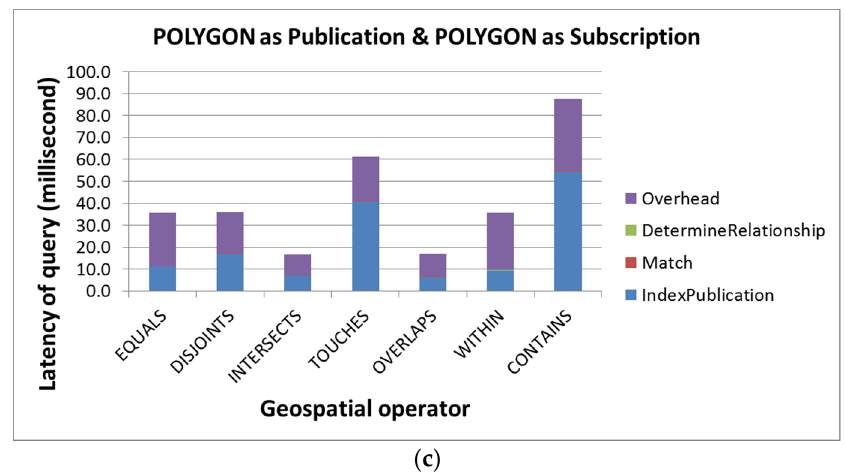
Figure 9. The end-to-end query performance for polygon as subscription and ( a ) point; ( b ) line; and ( c ) polygon geometry as publication.